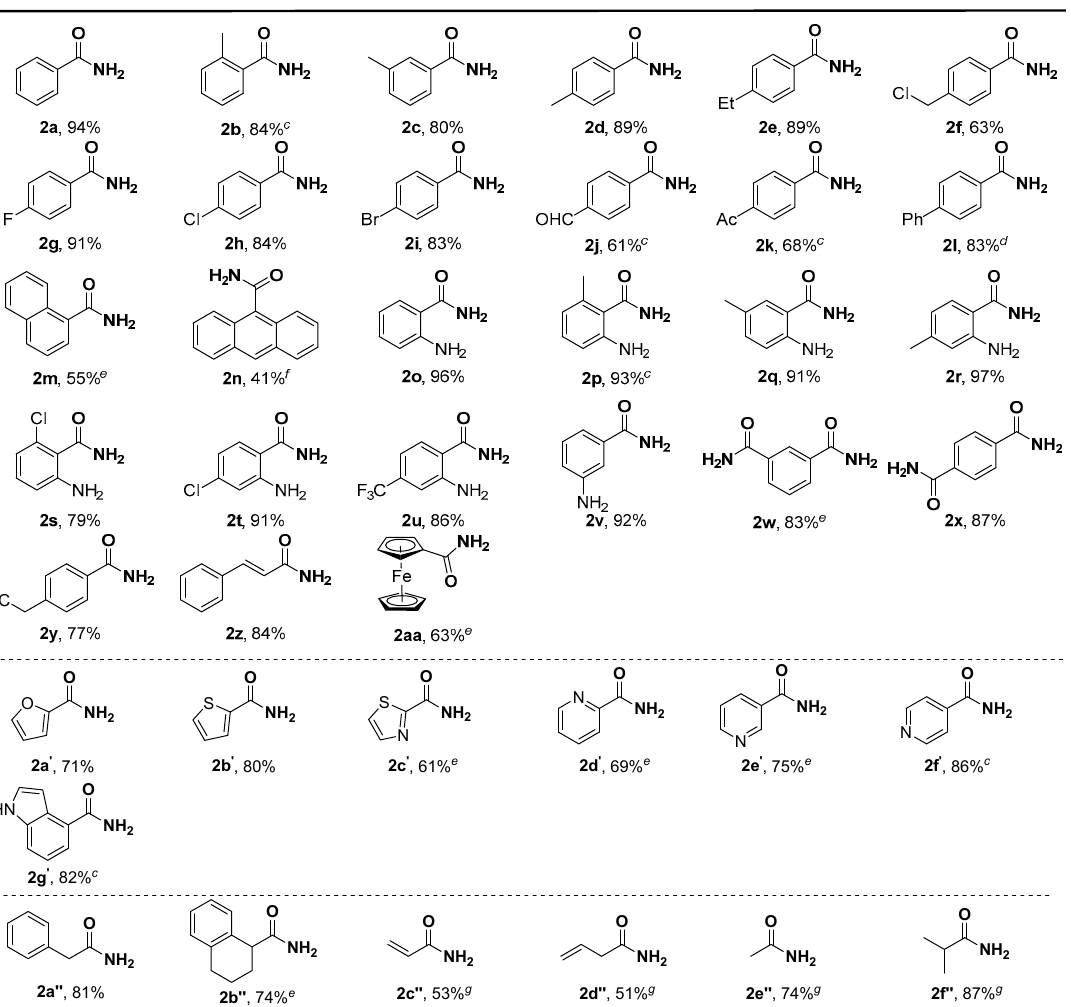
Molecules 2019 , 24 , x FOR PEER REVIEW 6 of 16 Table 4. The substrate scope for the hydration of nitriles 1 in WEPPA a,b Table 4. The substrate scope for the hydration of nitriles 1 in WEPPA a,b .